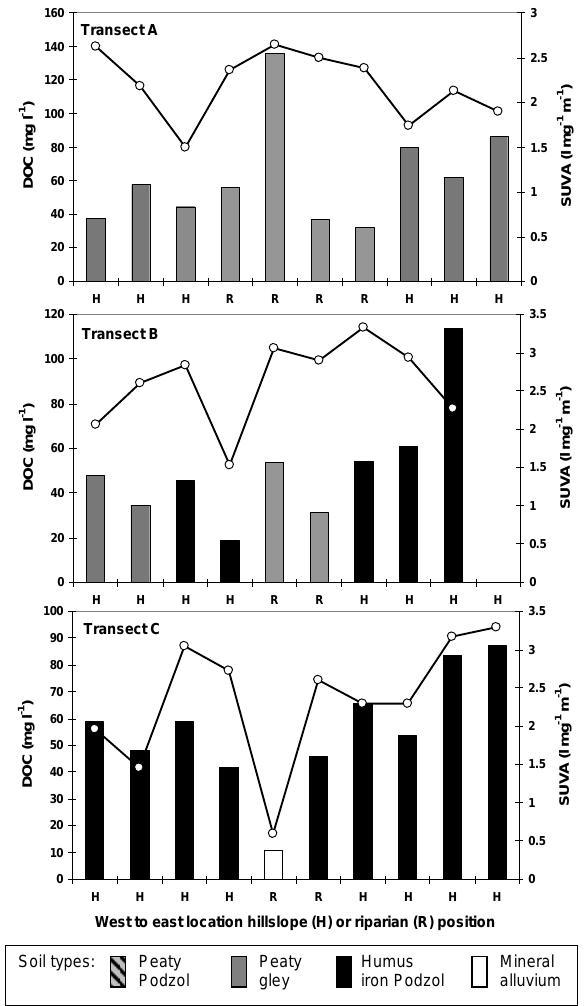
Fig. 5. Spatial changes in surface soil solution DOC concentration Figure 5. Spatial changes in surface soil solution DOC concentration (bars) and 47 (bars) and SUVA (line) over three 300m transects (A upstream, B SUVA (line) over three 300 m transects (A upstream, B middle, C downstream) 48 middle, C downstream) perpendicular to the stream channel span- perpendicular to the stream channel spanning hillslope to riparian (shaded area of 49 ning hillslope to riparian (shaded area of graphs) locations. Differ- graphs) locations. Different soil types are denoted by the fill pattern of the graph bars. 50 ent soil types are denoted by the fill pattern of the graph